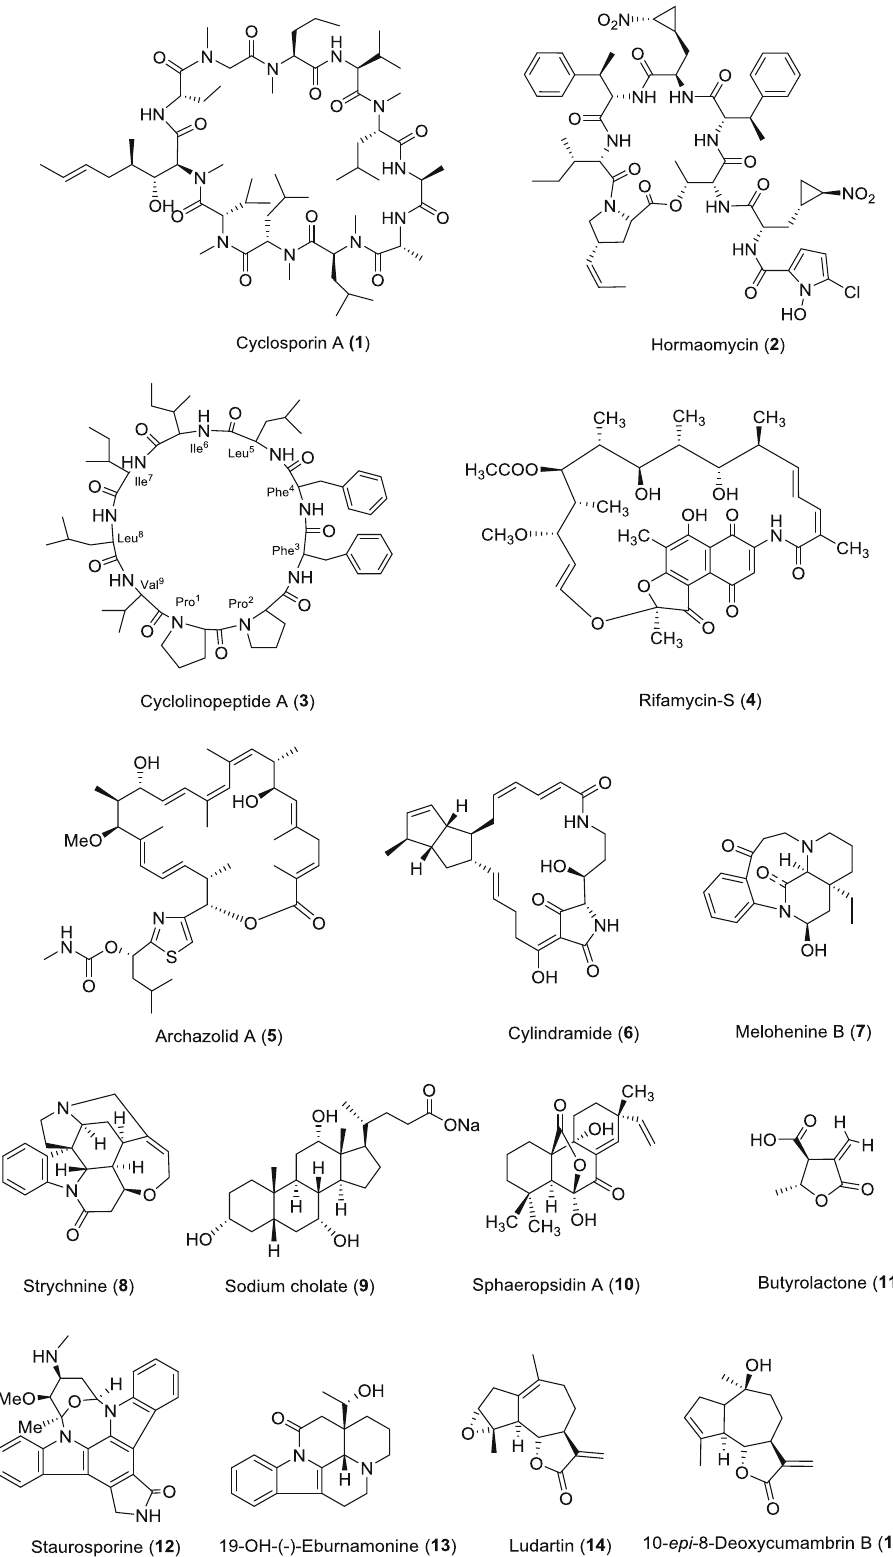
Fig. 9 Natural product with the stereochemistry assigned by RDC